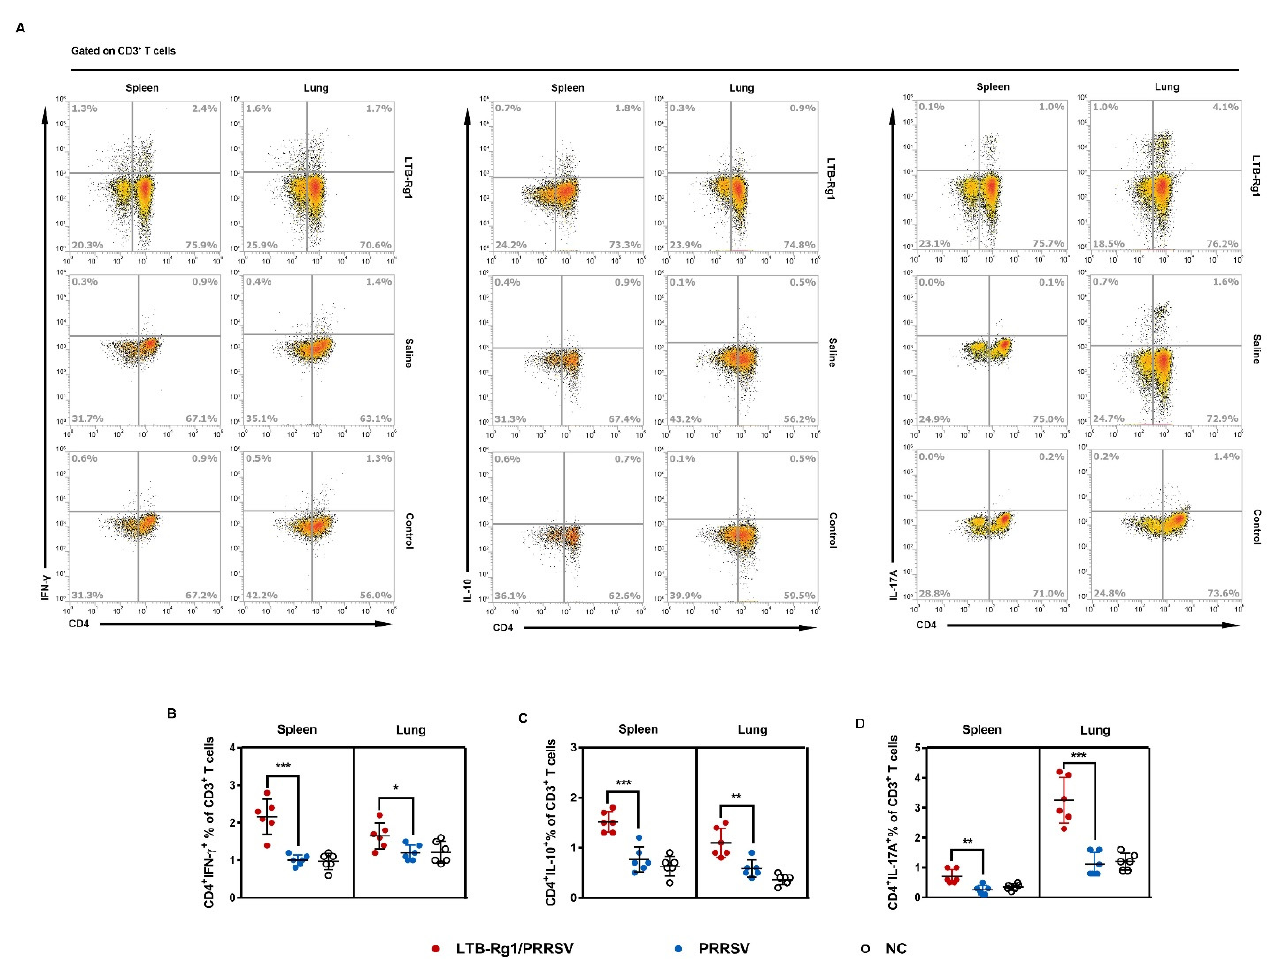
Figure 8. LTB-Rg1 significantly increased cytokine-producing T cells. Mice ( n = 6/group) received PRRSV vaccine without or with LTB-Rg1on days 0, 7, and 21. On day 35, splenocytes and lung mononuclear cells were collected and analyzed by flow cytometry. ( A , B ) Percentages of interferon (IFN)- γ + CD4 + T cells. ( A , C ) Percentages of IL-10 + CD4 + T cells. ( A , D ) Percentages of IL-17A + CD4 + T cells. Data are expressed as means ± SD. * p < 0.05, ** p < 0.01, *** p < 0.001.